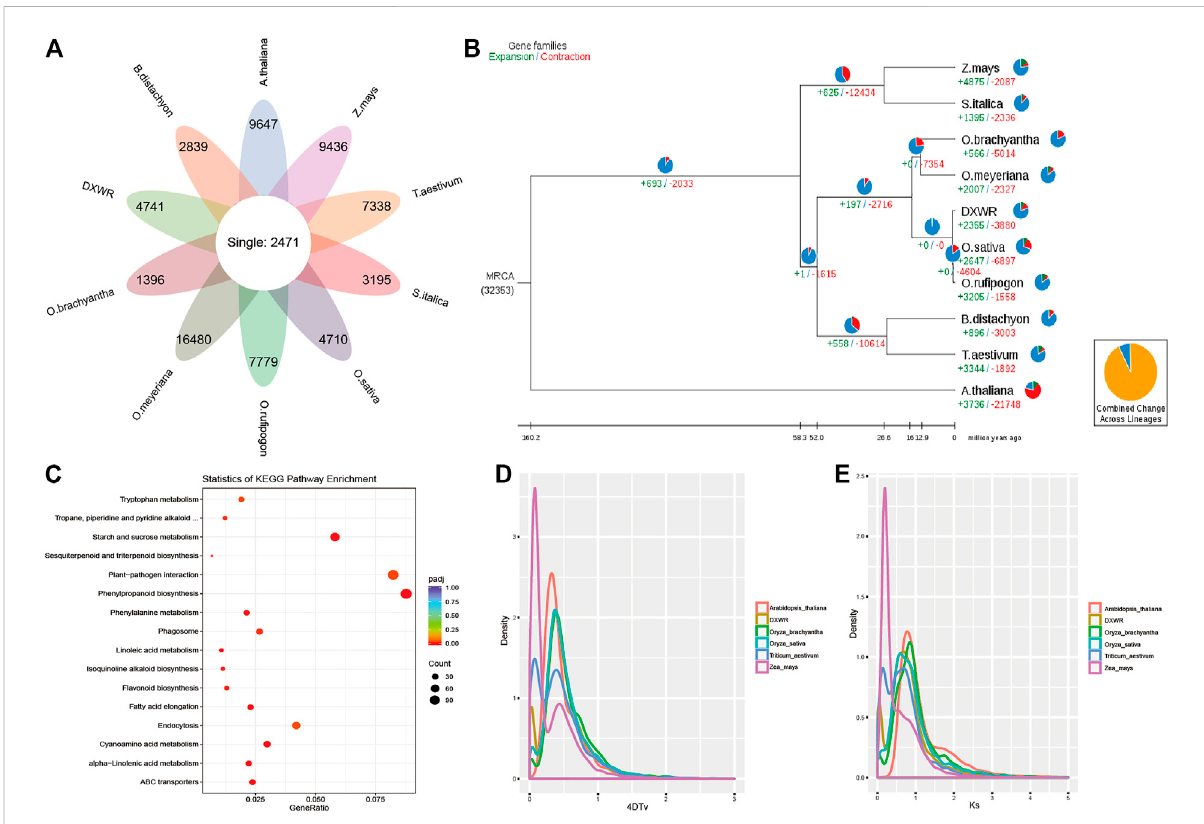
FIGURE 4 Comparative genomics and evolutionary analysis. (A) The orthologues genes and speci fi c genes of ten species. (B) Phylogenetic relationship and expanded/contracted gene families. (C) KEGG enrichment results of the expanded gene families. (D,E) 4DTv and Ks